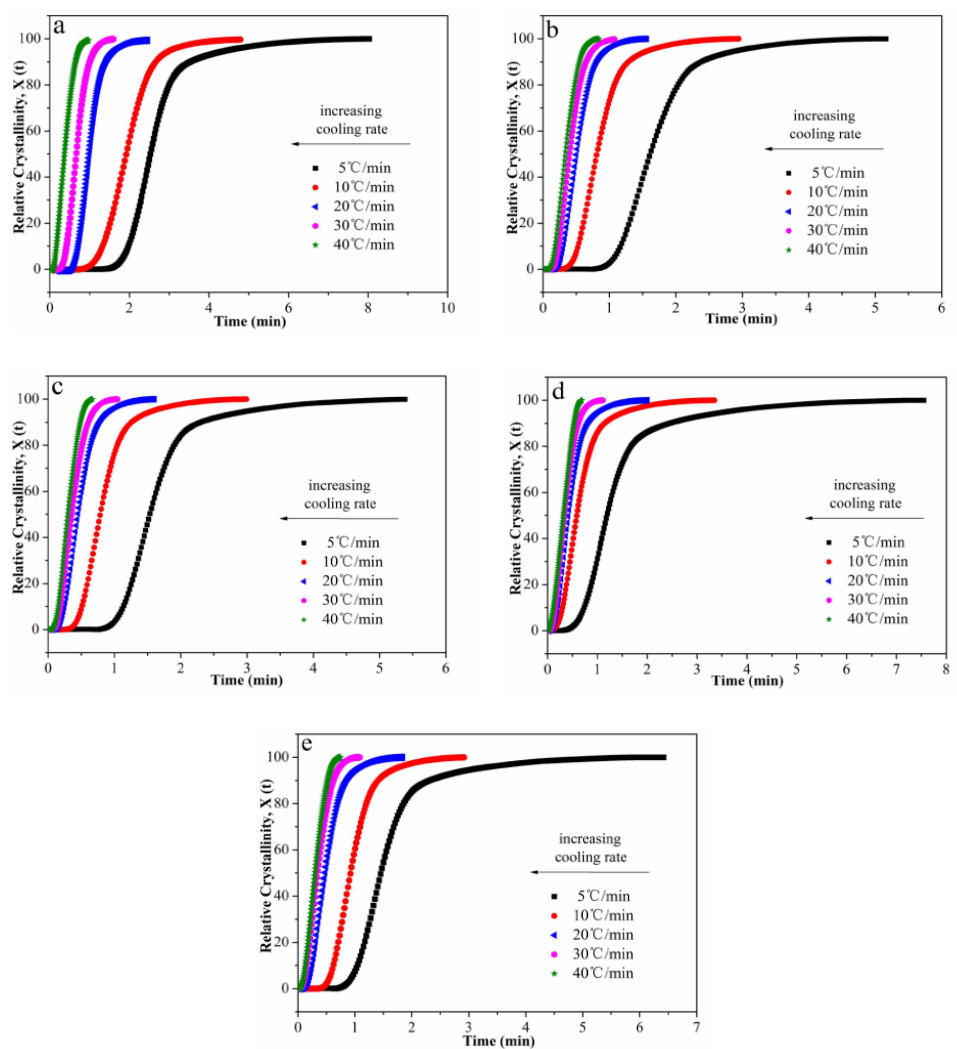
Figure 6. Relative degree of crystallinity as a function of temperature for POM/Ag nanocomposites with different Ag nanoparticle contents: ( a ) 0, ( b ) 0.1, ( c ) 0.5, ( d ) 1, ( e ) 2 wt % at the cooling rates of 5, 10, 20, 30 and 40 °C/min.